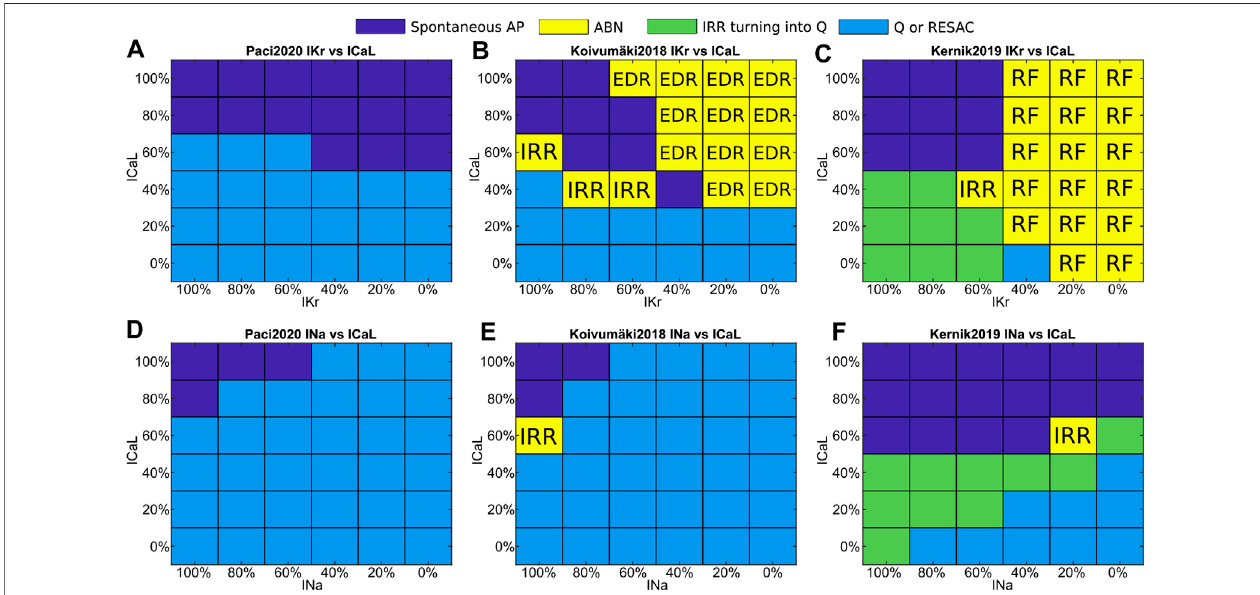
FIGURE6 | Sensitivitymaps tosimultaneous I Kr and I CaL blocks (A and B, C) or I Na and I CaL blocks (Dand E,F) . Colorcode: Spontaneous APs, blue; quiescence or residual activity, cyan; transient irregular rhythm turning into quiescence, green; arrhythmic events, yellow. The yellow squares include also the event type: irregular rhythm (IRR), repolarization failure (RF), and simultaneous occurrence of EAD, DAD and repolarization failure (EDR).